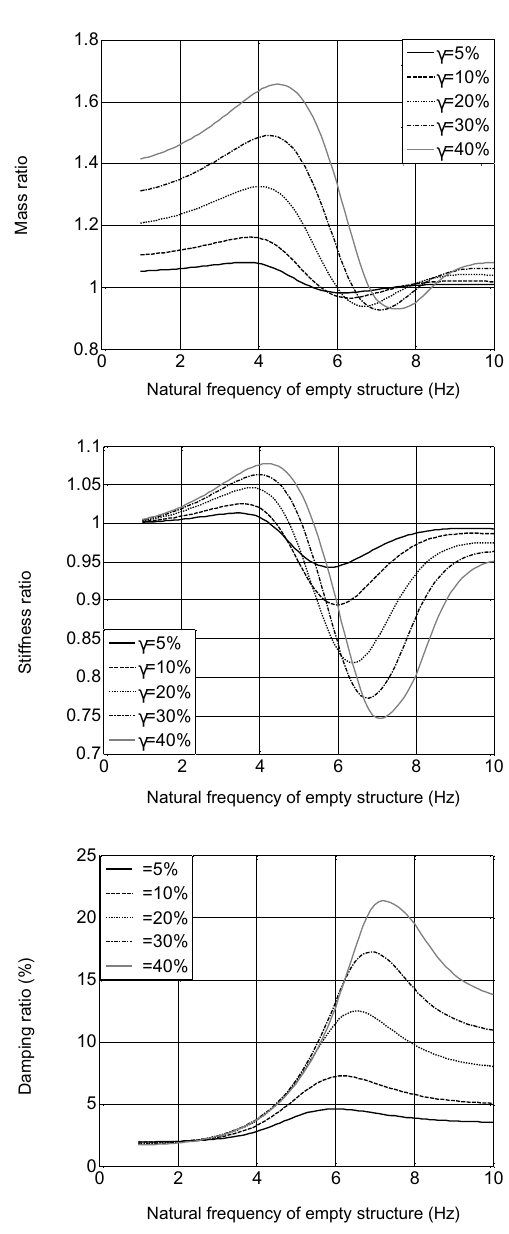
Fig. 5. Mass, stiffness and damping ratios for the equivalent SDOF system of a 50:50 seated/standing joint crowd-SDOF system, for a structure having a 2% damping ratio when